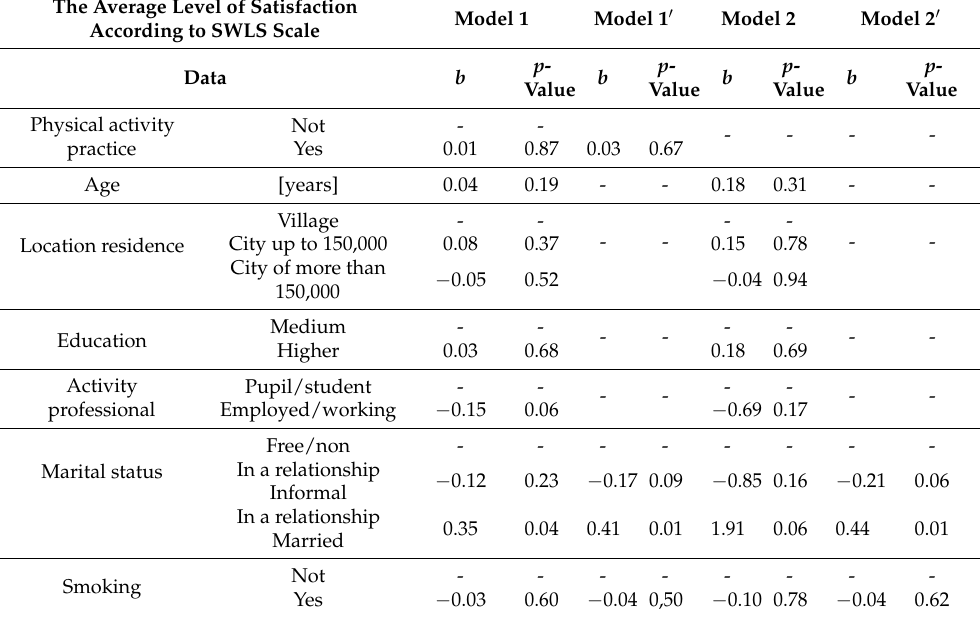
Table 2. The results of multivariate analysis for the level of satisfaction according to the SWLS scale in relation to physical activity practice or frequency of physical fitness.